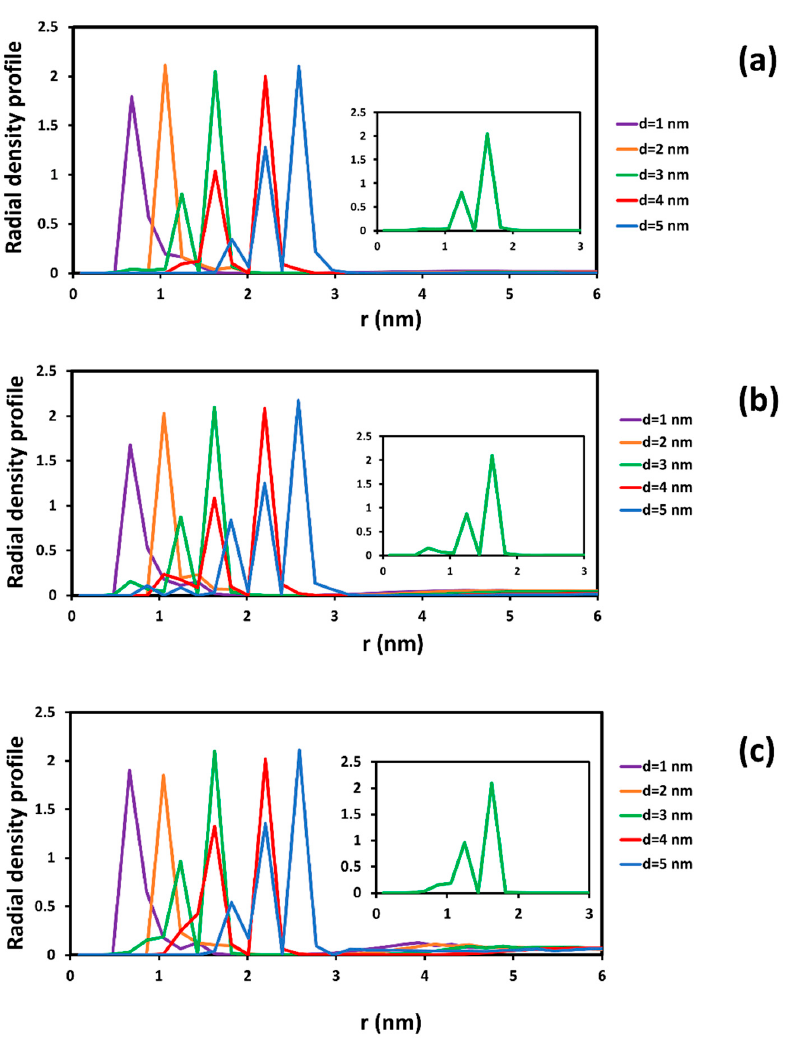
Figure 5. Radial density profile of surfactant inside CNTs at different total concentration of SDS: 1 wt % ( a ); 2 wt % ( b ); and 3 wt % ( c ). The insets in each figure exhibit enlargements of radial density profile with respect to distance (r) from 0 to 3 nm in case of SWCNT with diameter of 3 nm. Table 2. Percentage adsorption on the inside and outside surfaces of SWCNTs. Diameter of